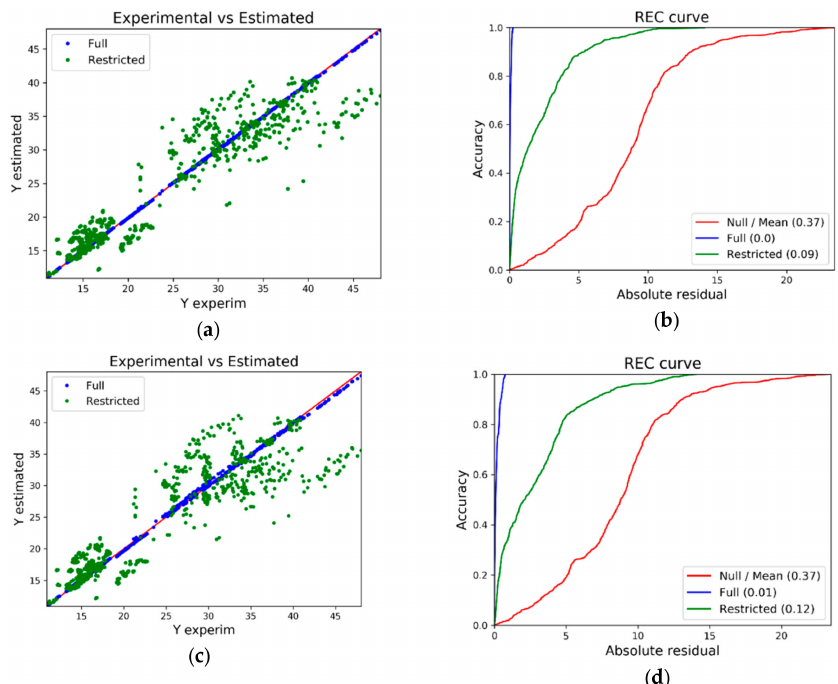
Figure 15. Results of the cooling load problem ( a ) Estimated vs experimental values for the full and restricted models for the eight-variable dataset with parameter selection h = ω = 0.033; ( b ) REC curve for the full, restricted and null (mean) models for the eight-variable dataset with parameter selection h = ω = 0.033; ( c ) Estimated vs experimental values for the model with five variables and h = ω = 0.033; ( d ) REC curve for the model with five variables and h = ω = 0.033.